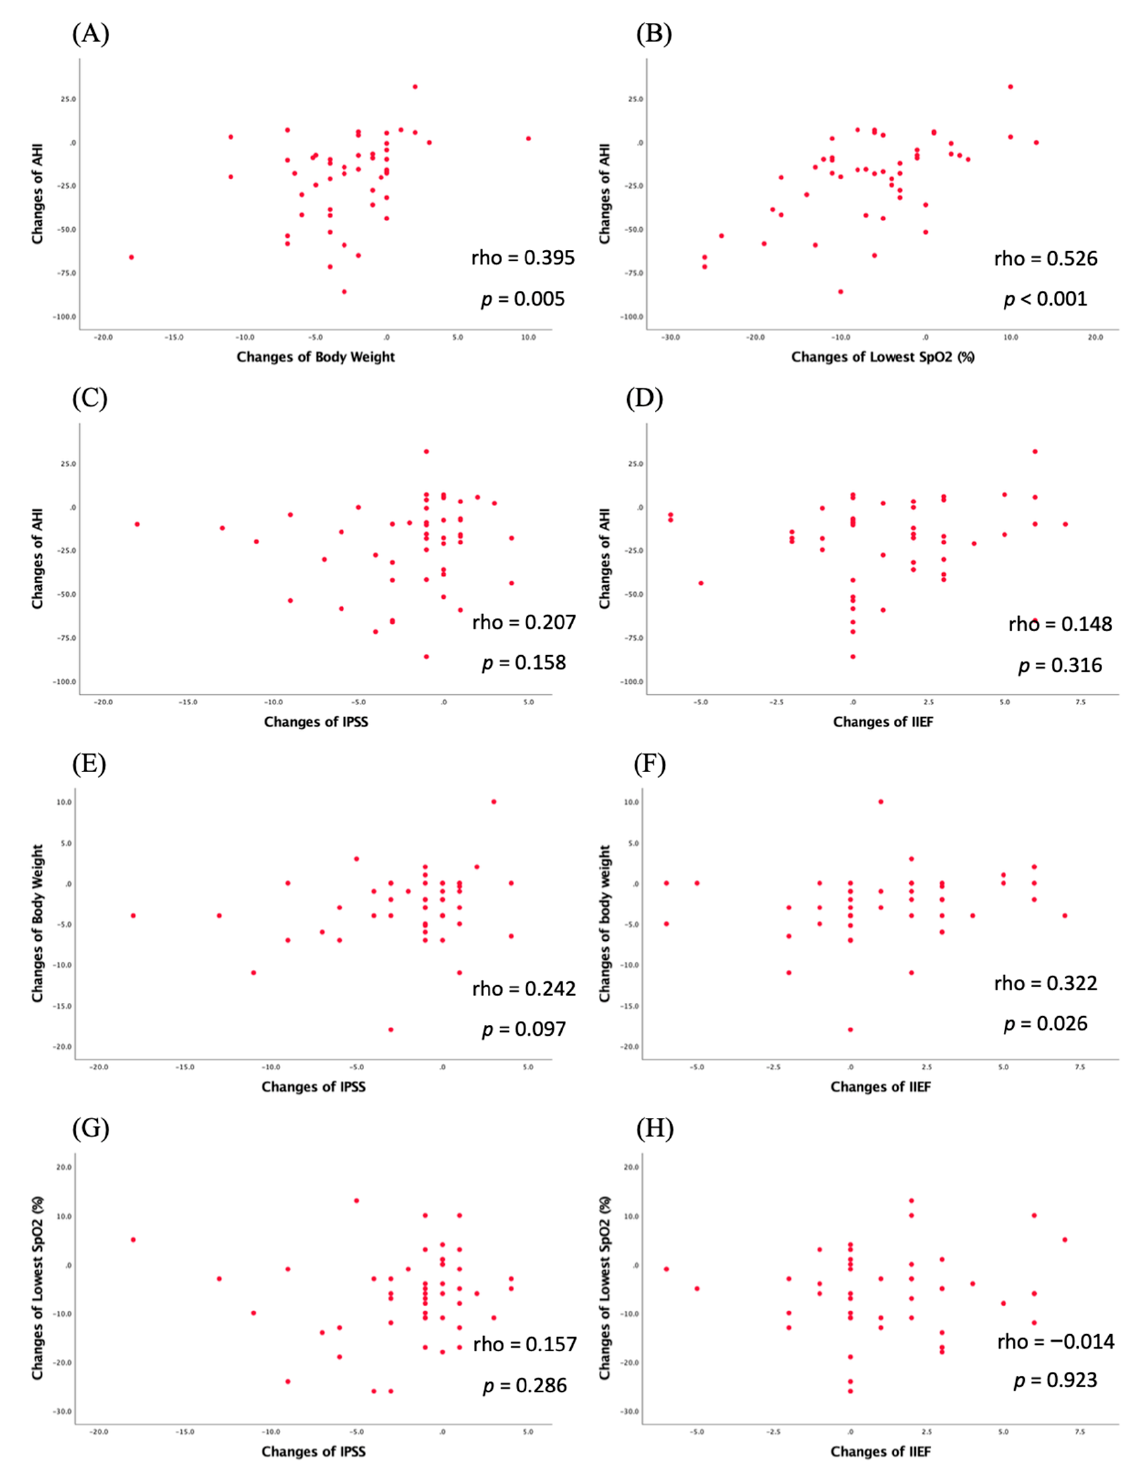
Figure 1. The association between AHI, lowest SpO 2, body weight, IPSS, and IIEF. ( A , B ) Correlation between the changes in AHI and the changes in BW and the lowest SpO 2 ; ( C , D ) correlation between changes in AHI and changes in IPSS and IIEF; ( E , F ) correlation between the changes in BW and the changes in IPSS and IIEF; ( G , H ) correlation between the changes in the lowest SpO 2 and the changes in IPSS and